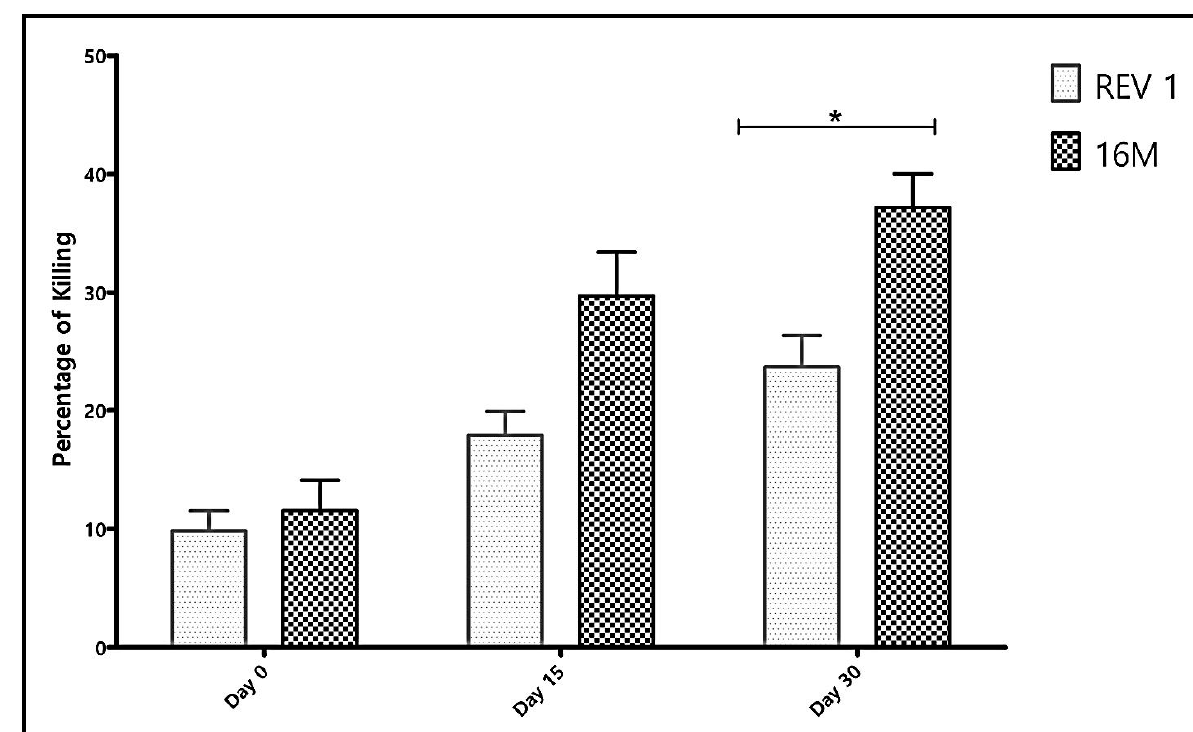
Figure 1. Arithmetic mean value of the combined percentages of Brucella cell killing of the four serum samples in correlation with post-vaccination time period. Percentage of cell killing is increased with post-vaccination time course (two-way ANOVA p < 0.001). Bonferroni post hoc test analysis of the mean values showed stronger killing of 16M in comparison to Rev.1 among all serum samples tested, being non-significant at day 0 ( p > 0.05); and day 15 ( p > 0.05) and turning out significant at day 30 (* p < 0.001), respectively. Bars stand for standard deviation.